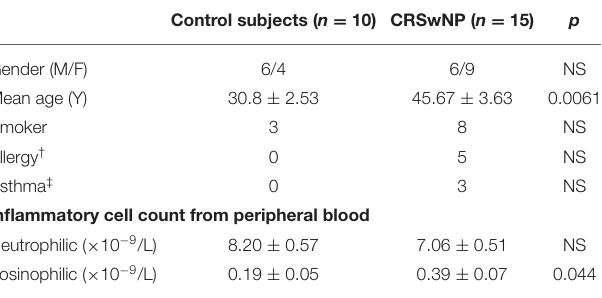
TABLE 1 | Patients’ characteristics.